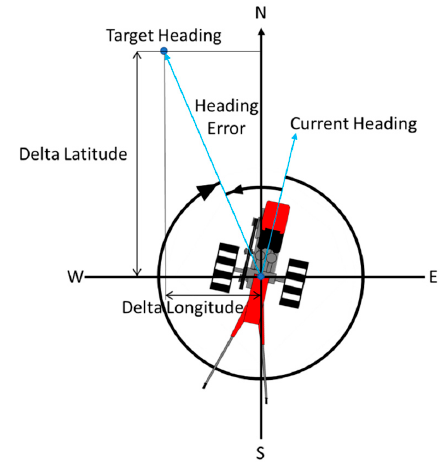
Figure 10. Tractor heading